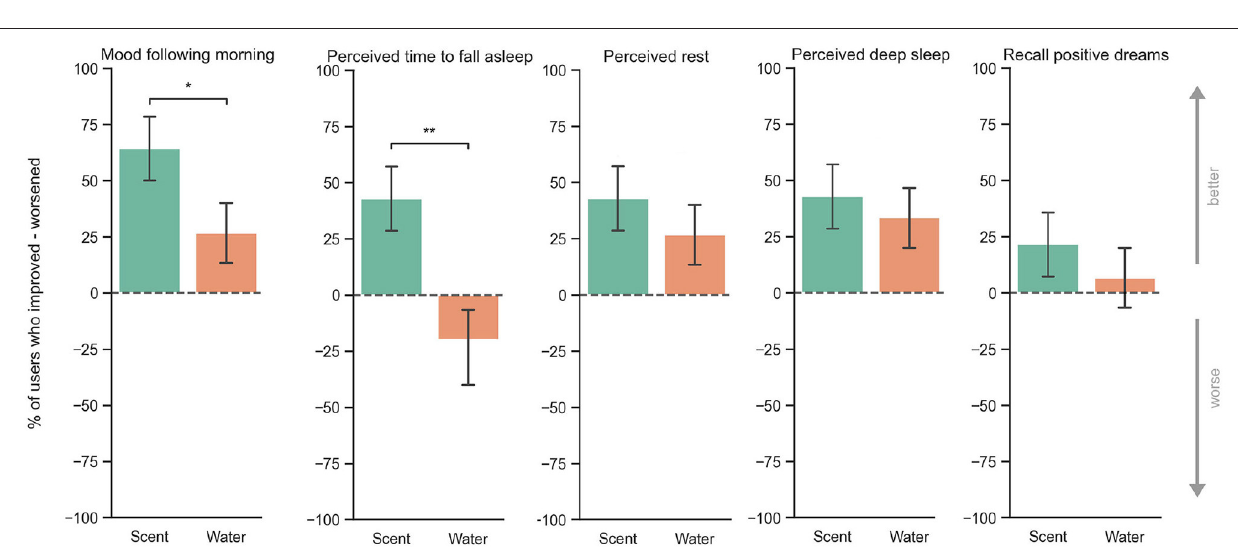
FIGURE 9 | In turquoise, experimental condition using the prototype with a lavender-based essential oil. In orange, prototype with water. The bars depict the percentage of participants who reported improvement minus those participants who reported worsening their sleep. Participants that were in the scent condition had on average more improvement than those in the control condition (water). * P < 0.05, ** P <